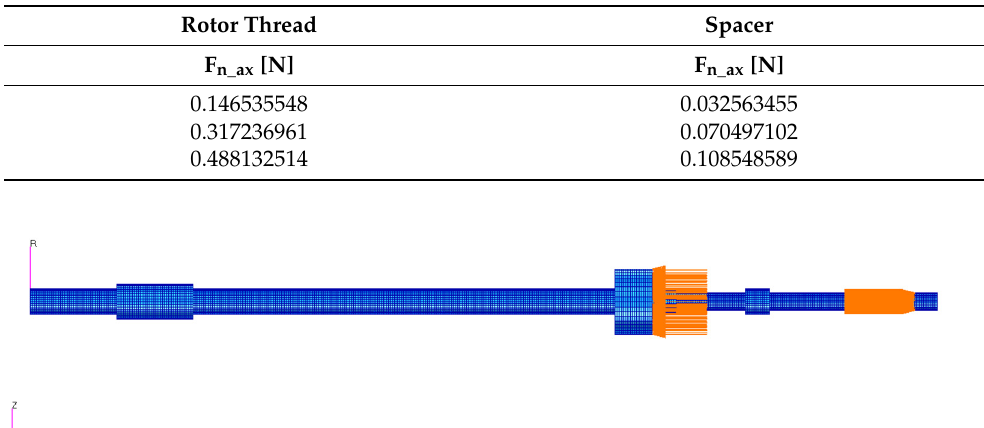
Table 6. Rotor thread and spacer loads.